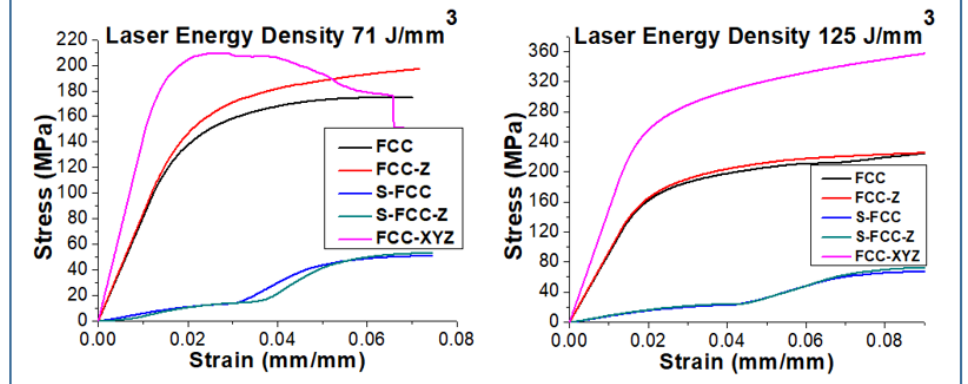
Figure 10. The flexural stress–strain curve from the three-point bending test of FCC-based lattices affected by lattice geometries.